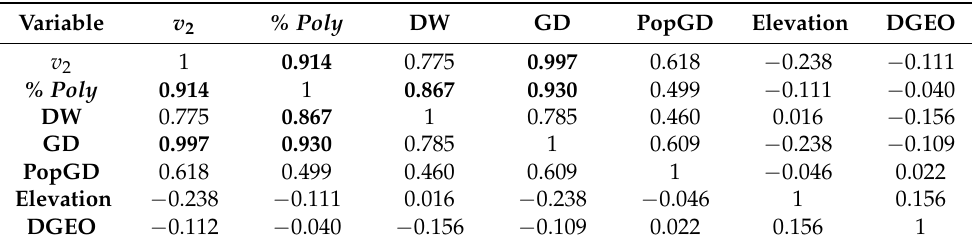
Table 4. Correlations between genetic and geographical variants of Pinus durangensis and the different peripheral and central populations of this species.